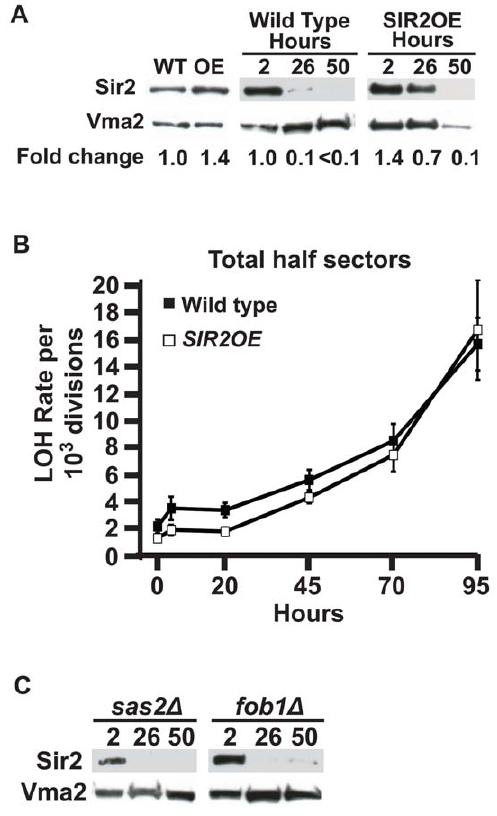
Figure 6. Declining Sir2 levels do not correlate with the onset of age-associated LOH events. A) Western blotting against Sir2 and Vma2 in total protein extracts prepared from cells aged for hours as indicated at top. Sir2 levels were normalized to Vma2 and quantified by densitometry, with wild type Sir2 levels in log cultures set to 1x Fold. Mean bud scar counts at 26 hours: WT=15.5, SIR2OE =18.0. B) Total LOH rates at MET15 of wild type UCC5185 (filled squares) compared to the SIR2OE strain UCC8910 (open squares). Error bars indicate SEM. C) Western blotting against Sir2 and Vma2 in total protein extracts prepared from aged cells. Genotype and hours of aging indicated at top. Mean bud scar counts at 26 hours: sas2 D =16.8, fob1 D =15.7.